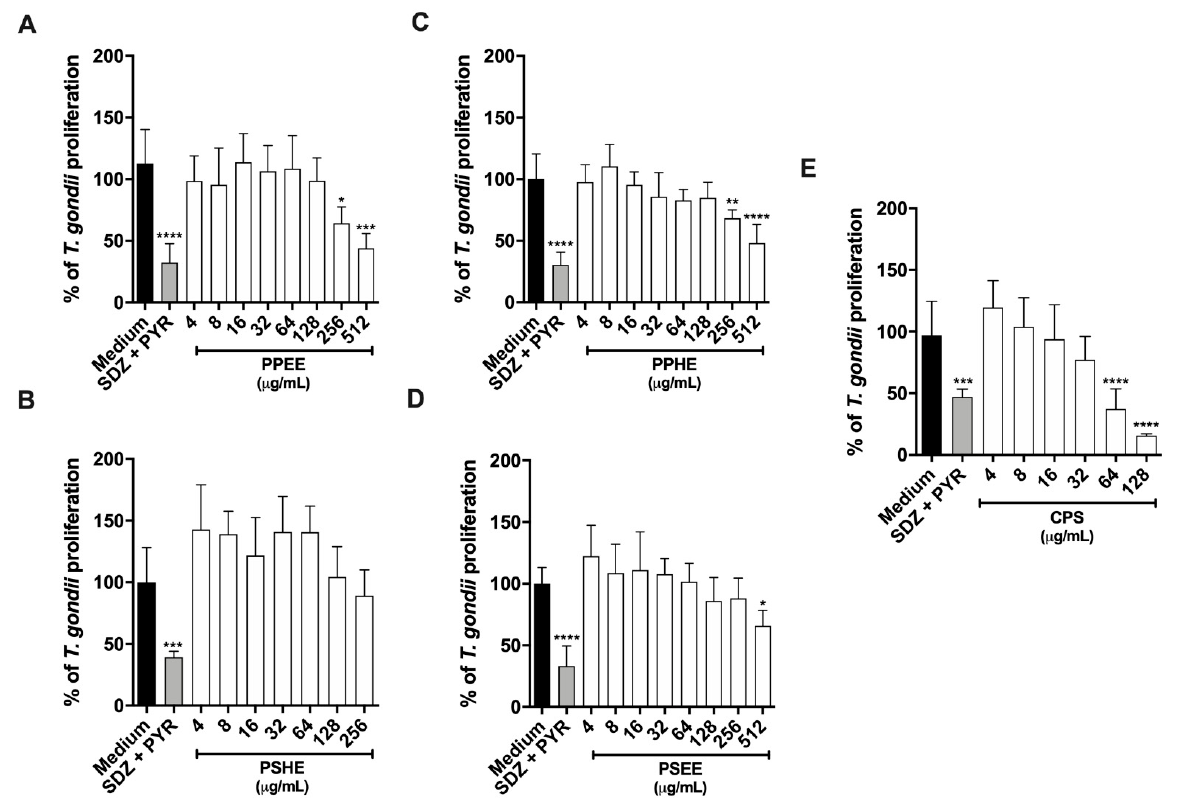
Figure 5. T. gondii intracellular proliferation. For 24 h, T. gondii -infected BeWo cells were treated with non-toxic concentrations in twofold serial dilutions, as follows: PPEE ( A ), PPHE ( B ), and PSEE ( C ), (all at concentrations ranging from 4 to 512 μ g/mL), PSHE (4 to 256 μ g/mL) ( D ), and CPS (4 to 128 μ g/mL) ( E ), Significant differences detected by the Kruskal–Wallis test and Dunn’s multiple comparison post-test are labeled (statistically significant when p < 0.05). * Comparison between infected/untreated cells and infected/treated cells. * p < 0.05, , ** p < 0.01 *** p < 0.001, **** p < 0.0001. 2.5.3. CPS Potentiates the action of SDZ + PYR to Control Parasite Growth For 24 h, intracellular T. gondii tachyzoites were allowed to grow in BeWo cells in the presence of SDZ + PYR (200 + 8 μ g/mL, respectively) alone or in combination with differ- ent CPS concentrations (4 to 128 μ g/mL). Association of SDZ + PYR with CPS (4 to 128 μ g/mL) significantly reduced parasite proliferation compared to CPS alone (Figure 6). In addition, only the combination of SDZ + PYR with 64 μ g/mL CPS inhibited T. gondii growth significantly more effectively than SDZ + PYR alone and CPS alone (Figure 6).